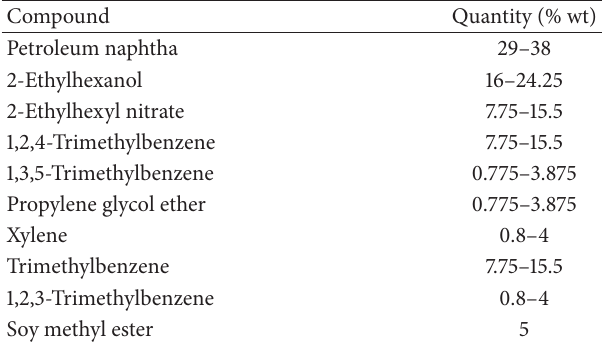
Table 2: Fuel additive